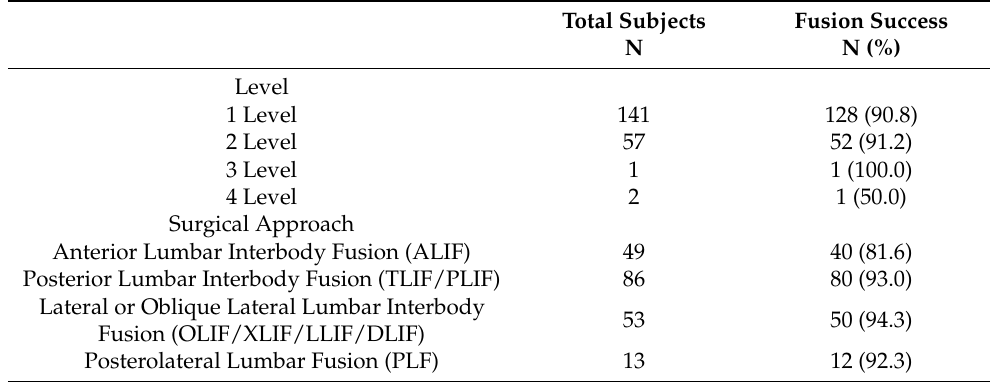
Table 2. Fusion Success at 12 months by Level Treated and Surgical Approach.